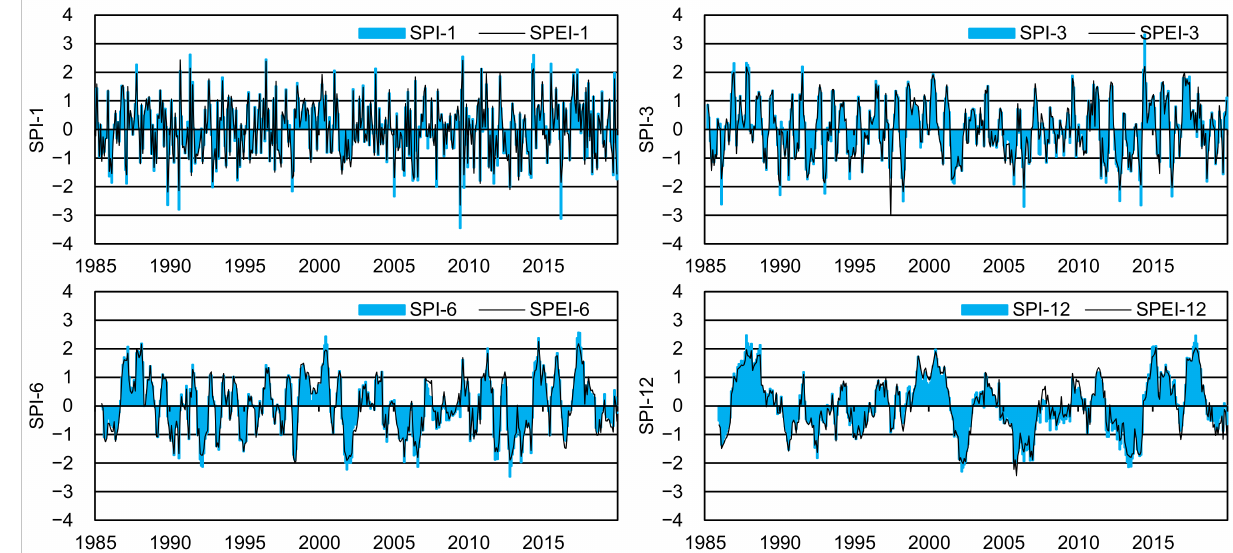
Figure 8. Comparison of the SPI and SPEI at 1-, 3-, 6-, and 12-month timescales at the Pusat Pertanian Charok Padang station from 1985 to 2019.